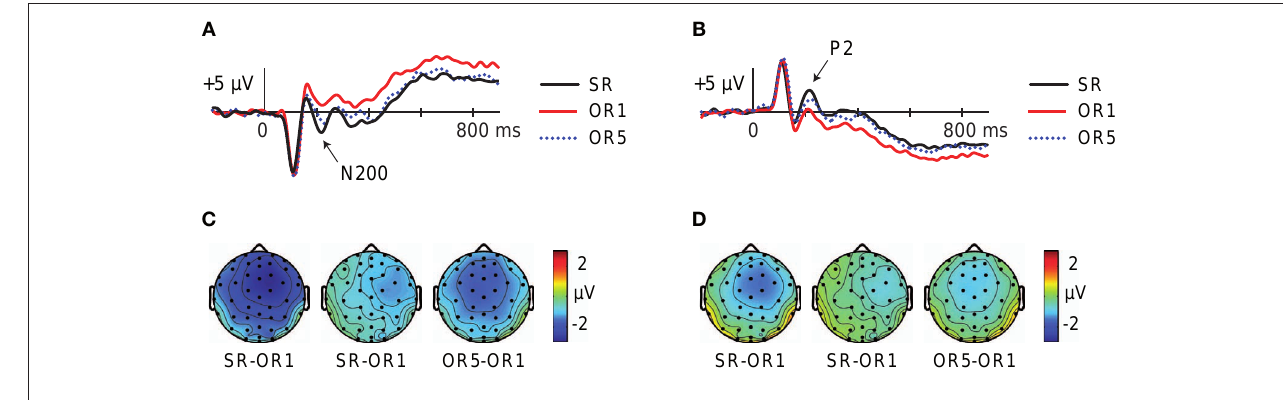
FiGuRE 4 | Event-related potentials at encoding for SR, OR1, and OR5 faces, independent of subsequent memory. (a) Waveforms at frontocentral electrode Cza computed using a mastoid reference. (B) Waveforms at right-occipito-temporal electrode T2i computed using an